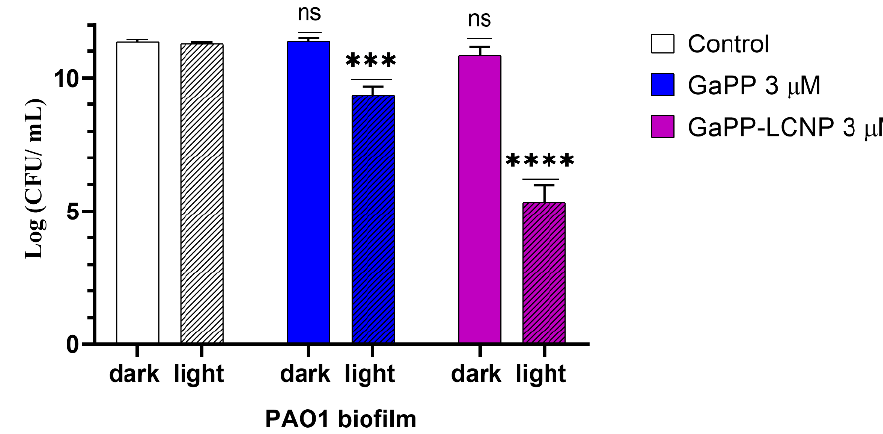
Figure 7. The viability of P. aeruginosa planktonic culture following treatment with GaPP and GaPP- LCNP (0.8 µ M), light dose of 17.2 J/cm 2 , compared to saline treated control in dark. Data presented as mean ± SD, n = 3. ns: non-significant reduction, **** significant reduction in viability, p value < 0.0001, ** p value = 0.001 (Two-way ANOVA followed by Dunnett’s multiple comparison test).